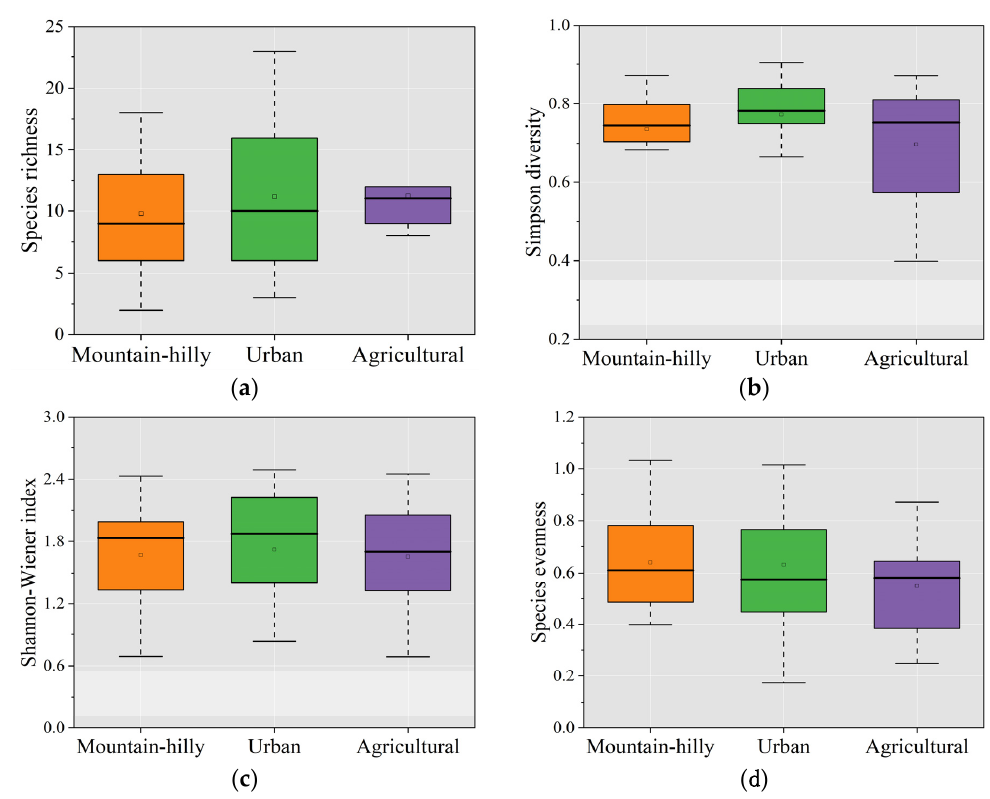
Figure 2. Box plots of taxonomic diversity indexes of richness, Simpson’s diversity, Shannon–Wiener index, and evenness of macroinvertebrates distributed across different land use types. The lines in the boxes represent the median, the boxes represent the 1st and 3rd quartiles, and the lines at the top and bottom of the boxes represent the 5th and 95th percentiles, respectively. ( a ) Species richness in different land use types; ( b ) species diversity in different land use types; ( c ) species Shannon–Wiener index in different land use types; ( d ) species evenness in different land use types.